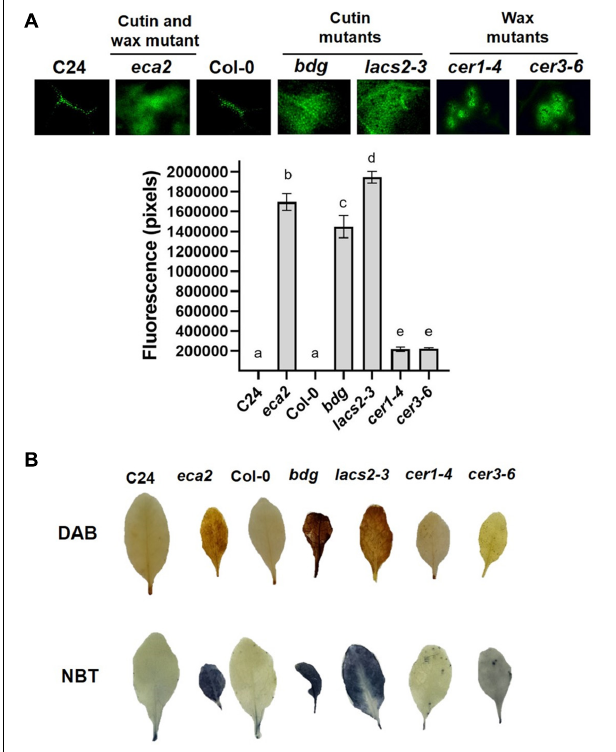
FIGURE 3 | Reactive oxygen species (ROS) accumulation in the cuticular mutants and WT plants. (A) DCF-DA staining was observed on leaves by using epifluorescence microscopy. (B) 3, 3 (cid:48) -diaminobenzidine (DAB) and nitroblue tetrazolium (NBT) were used to detect the accumulation of hydrogen peroxide (H 2 O 2 ) and superoxide (O 2 − ), respectively. Six independent experiments were carried out with similar results ( n = 6 ± SD). Scale bar = 100 µ m. Different lowercase letter columns indicate significant differences, according to one-way analysis of variance (ANOVA) ( p -value < 0.001) followed by Tukey’s test. Representative pictures are